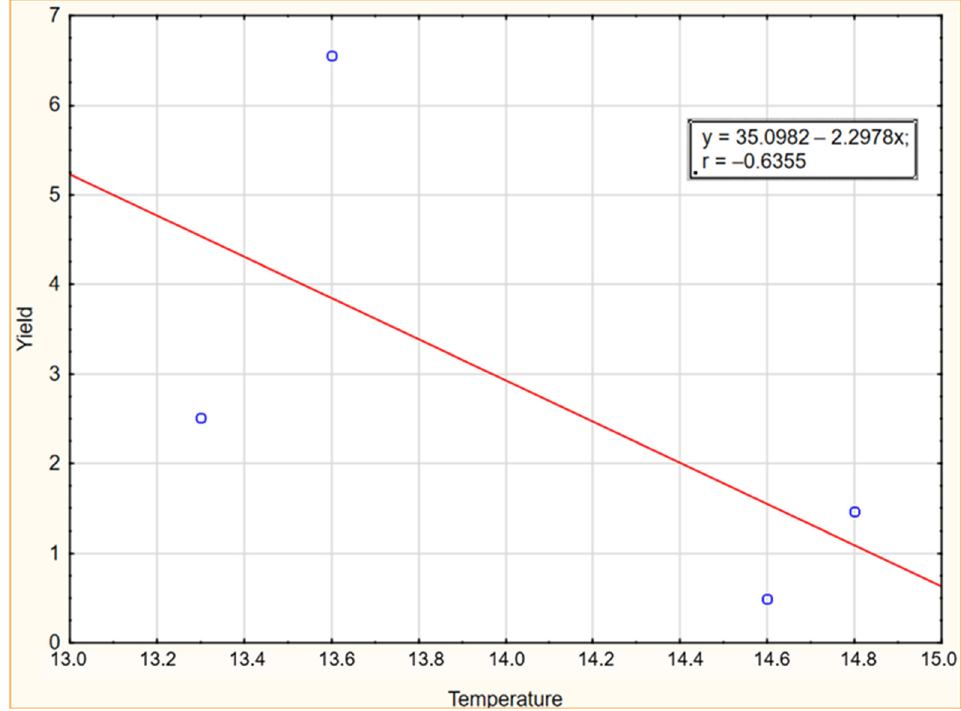
Figure 5. Scatter plot with correlation coefficient for yield and temperature in 2019–2022.